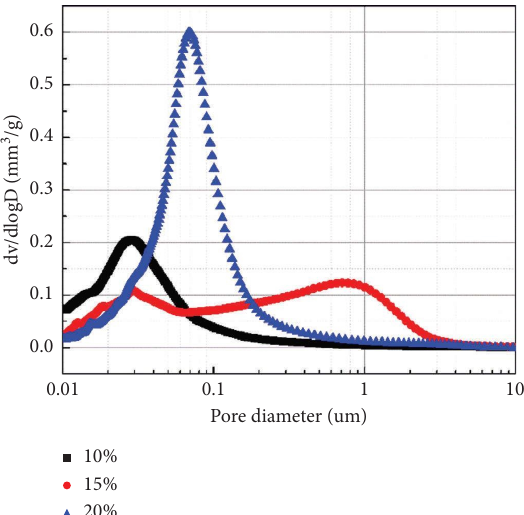
Figure 9: Te pore size distribution of FABG with diferent sodium hydroxide contents after curing at 90 ° C for 28d. Table 2: Te pore structure parameters of FABG with diferent sodium hydroxide contents after curing at 90 ° C for 28 d. NaOH content (%) 10 15 20 Porosity (%) 24.72 31.70 40.80 Average pore size (nm) 24.20